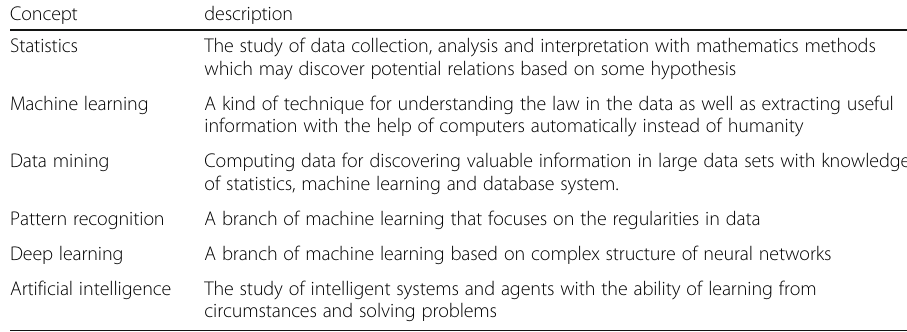
Table 4 Concepts related to data